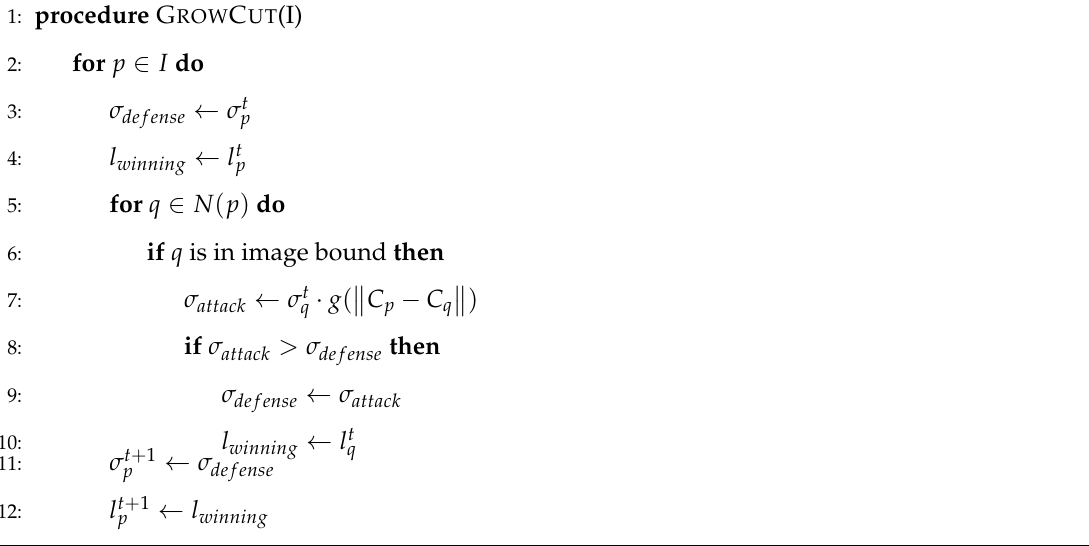
Algorithm 1 Classical GrowCut algorithm applied on an input image I